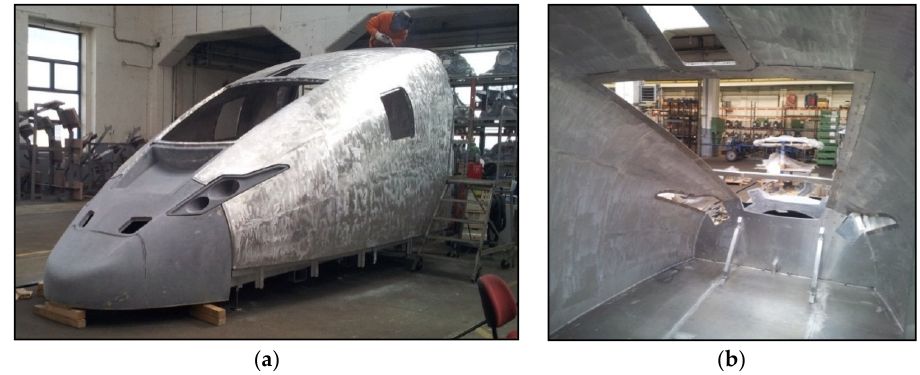
Figure 7. ( a ) Prototype of German high velocity train ICE made of welded aluminum foam sandwich;